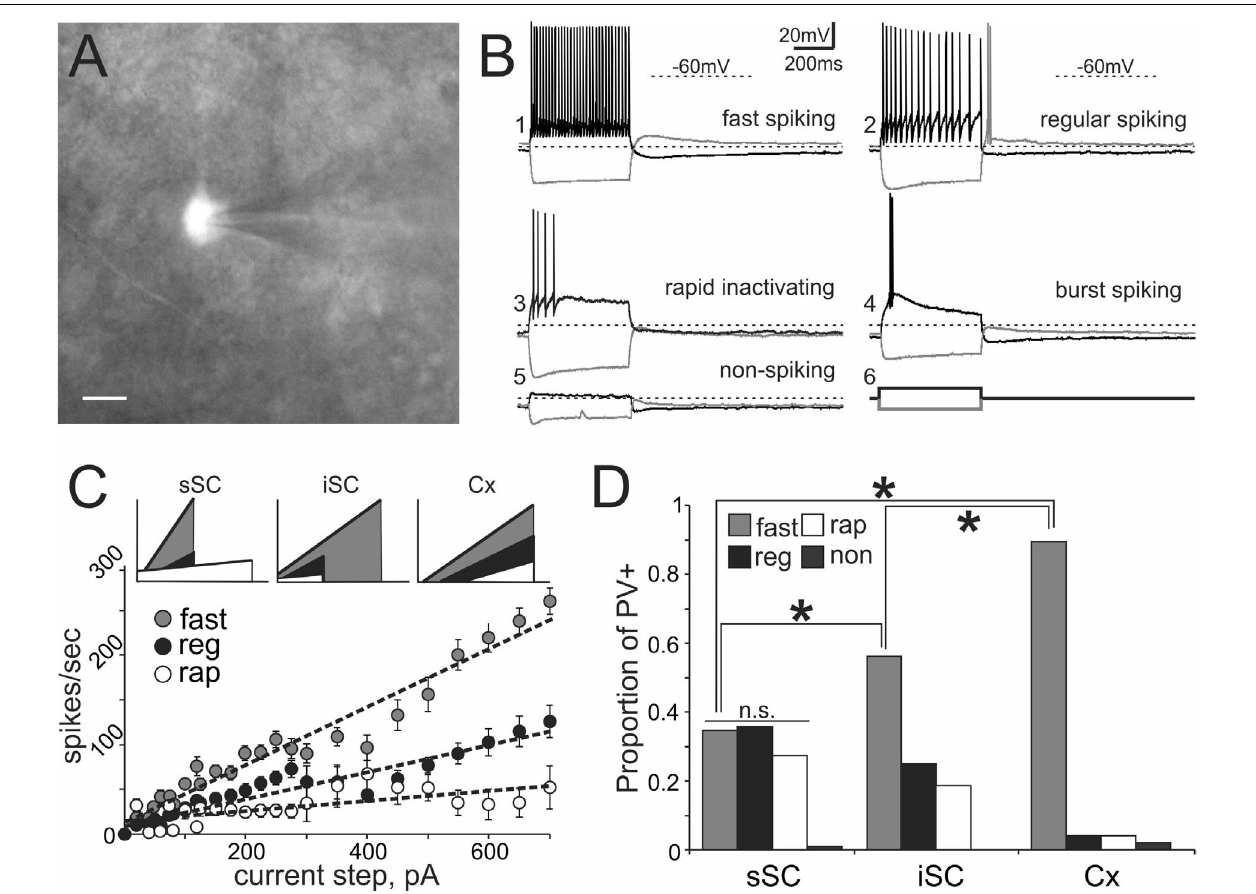
FIGURE 3 | PV + neurons in the SC show a variety of electrophysiological properties. (A) Visually identified and recorded PV + neuron from a brain slice of an Ai9;PV-Cre mouse. Scale bar: 10 µ m. (B) Representative traces from whole-cell patch-clamp recordings obtained from PV + neurons in the SC. (B 1 ) Shows fast spiking, (B 2 ) regular spiking, (B 3 ) rapidly inactivating, (B 4 ) burst spiking and (B 5 ) non-spiking. Gray and black traces represent voltages resulting from injection of negative and positive step currents (–100 pA/+100 pA, B 6 ), respectively. Dotted line, –60 mV applies to all five traces. Scale bar: 20 mV/200 ms. (C) Mean values of step current vs. spikes/sec (I/F) curves calculated from all recorded PV + neurons showing the most common spiking classes; fast (gray circles), regular (black circles) and rapidly inactivating (open circles). Dotted lines represent the linear regression computed for each of the classes. The I/F plots at the top provide a comparison of the linear regressions calculated for fast (gray), regular (black), and rapidly inactivating neurons (white) recorded from sSC (left), iSC (middle), and Cx (right). (D) Proportion of fast, regular, rapidly inactivating and non-spiking PV + neurons recorded in sSC, iSC, and Cx. ∗ p < 0.05, z -test.